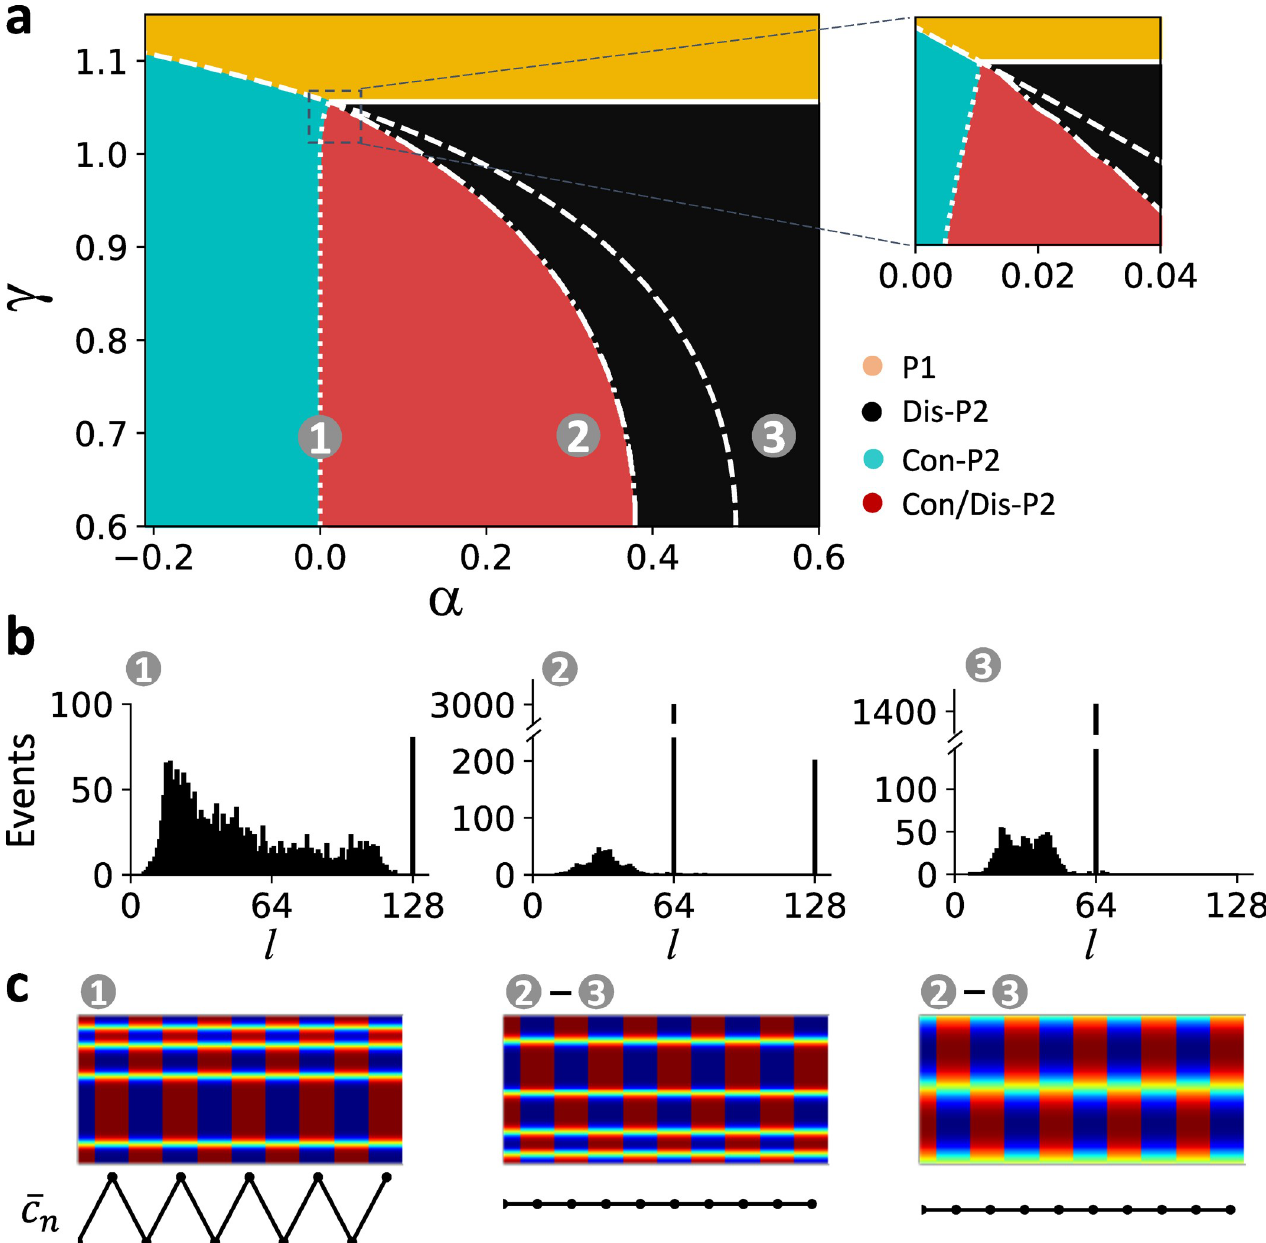
Fig 7. Bifurcations and spatiotemporal dynamics in the CML model. a . Phase diagram in the α - γ space showing stability boundaries and spatiotemporal dynamics of the CML model. The same color codes as in Fig 3A and Fig 5A were used. The solid line is the stability boundary of uniform P1 determined by Eq 7. The dashed line is the stability boundary of P1 in an uncoupled unit determined by Eq 6. The dash-dot line is the stability boundary of Con-P2 determined by Eq 8. The vertical dotted line is the stability boundary of Dis-P2 determined by numerical simulations of the CML model. Inset is the blowup of the marked region, showing that all the stability boundaries meet at a common point. b . Histograms of domain size at different locations in the phase diagram marked by numbers. The coordinates ( α , γ ) from location 1 to 3 are: (0, 0.7), (0.3, 0.7), and (0.55, 0.7). c . Sample spatiotemporal patterns (top) and the corresponding global signals (bottom) from different regions of the phase diagram. Number ranges above each pattern indicate the locations in the phase diagram where the specific pattern can be seen. where all phases meet (inset in Fig 7A), indicating that stable Dis-P2 patterns can only exist when α > 0. Histograms of domain size and example spatial patterns from three locations